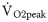
Distribution of the RMSEcv for different fitness categories.A) Model 1a; B) Model 1b; C) Model 2. The values in each bar represent the RMSEcv in [L/min] and, in parenthesis, the RMSEcv in percentage respect to the average V˙O2peak of the fitness category.